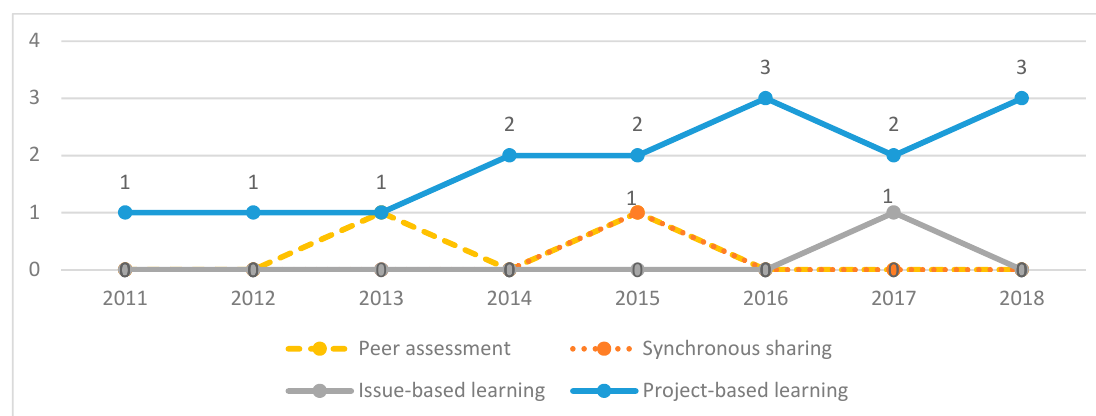
Figure 11. The number of papers published in learning strategies by year.